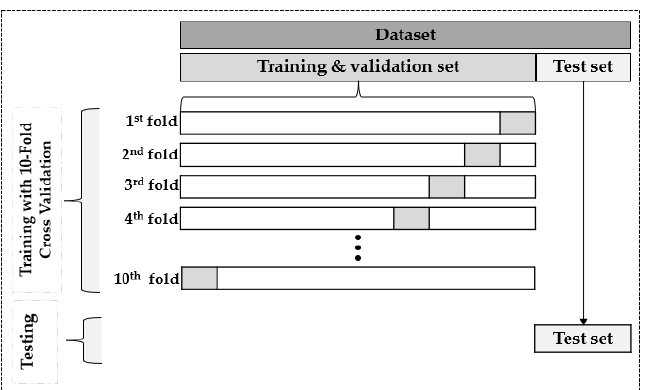
Figure 4 . Representation of the 10-fold cross-validation and the testing performed on the